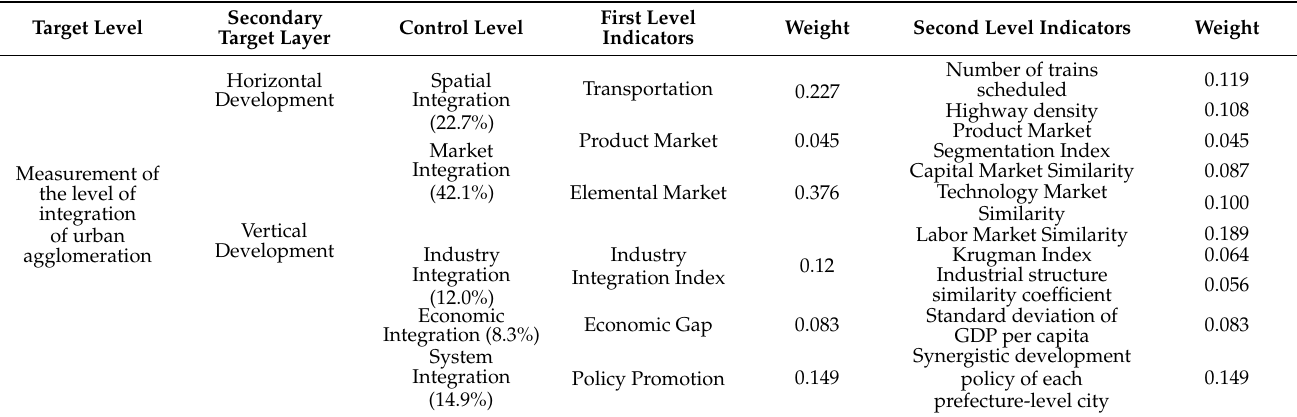
Table 1. Comprehensive Evaluation Index System of Integration Level of